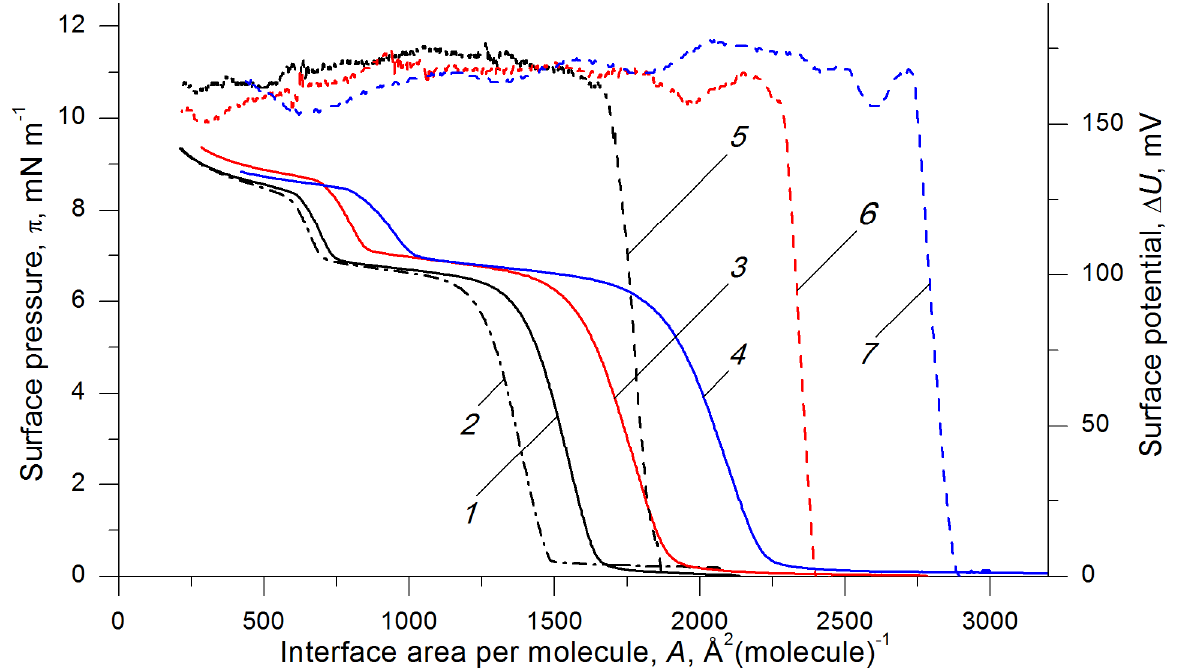
Figure 10. π -A ( 1 , 2 ) and Δ U-A ( 3 ) compression ( 1 , 3 ) and expansion ( 2 ) isotherms of Me 4 -15 Lang-